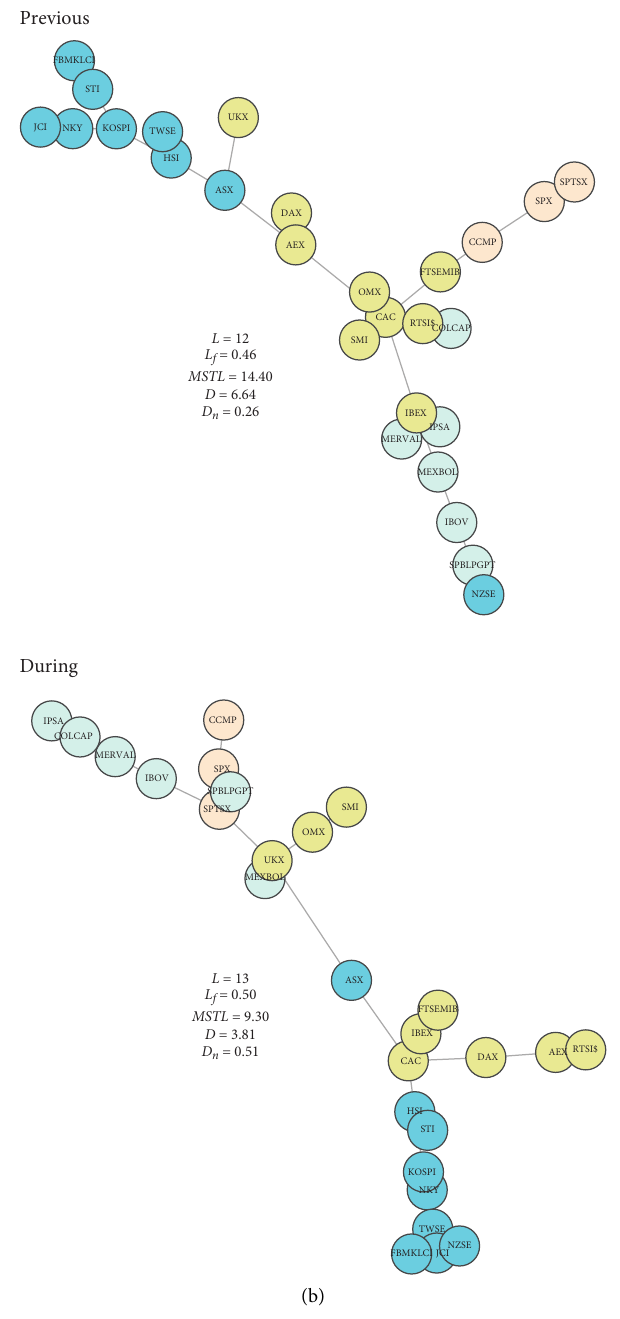
Figure 3: (a) Minimum spanning trees (MSTs) during the Subprime Crisis. This figure shows the resulting MSTfor three different periods. For comparison, we consider the quarters 6 months before and after where global markets fell sharply during Subprime Crisis: precrisis (January, February, and March 2008), crisis (September, October, and November 2008), and postcrisis (March, April, and May 2009). The color of the vertex represents different regions: (a) blue: Asia-Oceania, (b) light blue: Latin America, (c) light yellow: Europe, and (d) light salmon: North America. (b) Minimum spanning trees (MSTs) during the COVID-19 outbreak. This figure shows the resulting MSTfor two different periods. For comparison, we consider the quarter where global markets fell sharply during the COVID-19 outbreak and a quarter before: previous (November 2019 to January 2020) and during (February to April 2020) the outbreak. The color of the vertex represents different regions: (a) blue: Asia-Oceania, (b) light blue: Latin America, (c) light yellow: Europe, and (d) light salmon: North